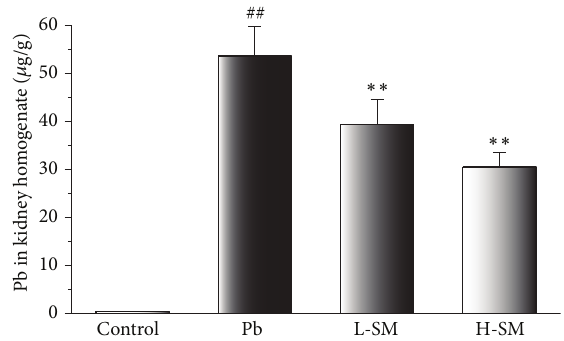
Figure 2: Effects of SM injection on concentrations of Pb in kidney homogenate. Samples were obtained from the control group, Pb group, L-SM group, and H-SM group. Data are expressed as mean ± SD of 20 mice. ## 𝑃 < 0.01 , compared with control group; ∗∗ 𝑃 < 0.01 , compared with Pb